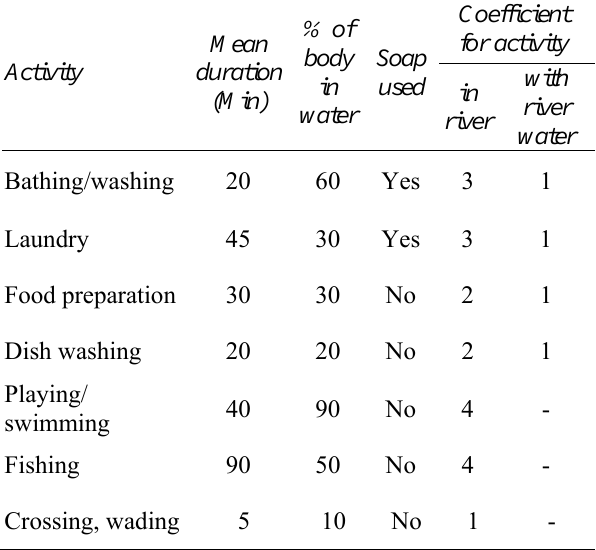
Table 1 : Coefficient used to quantify behaviors